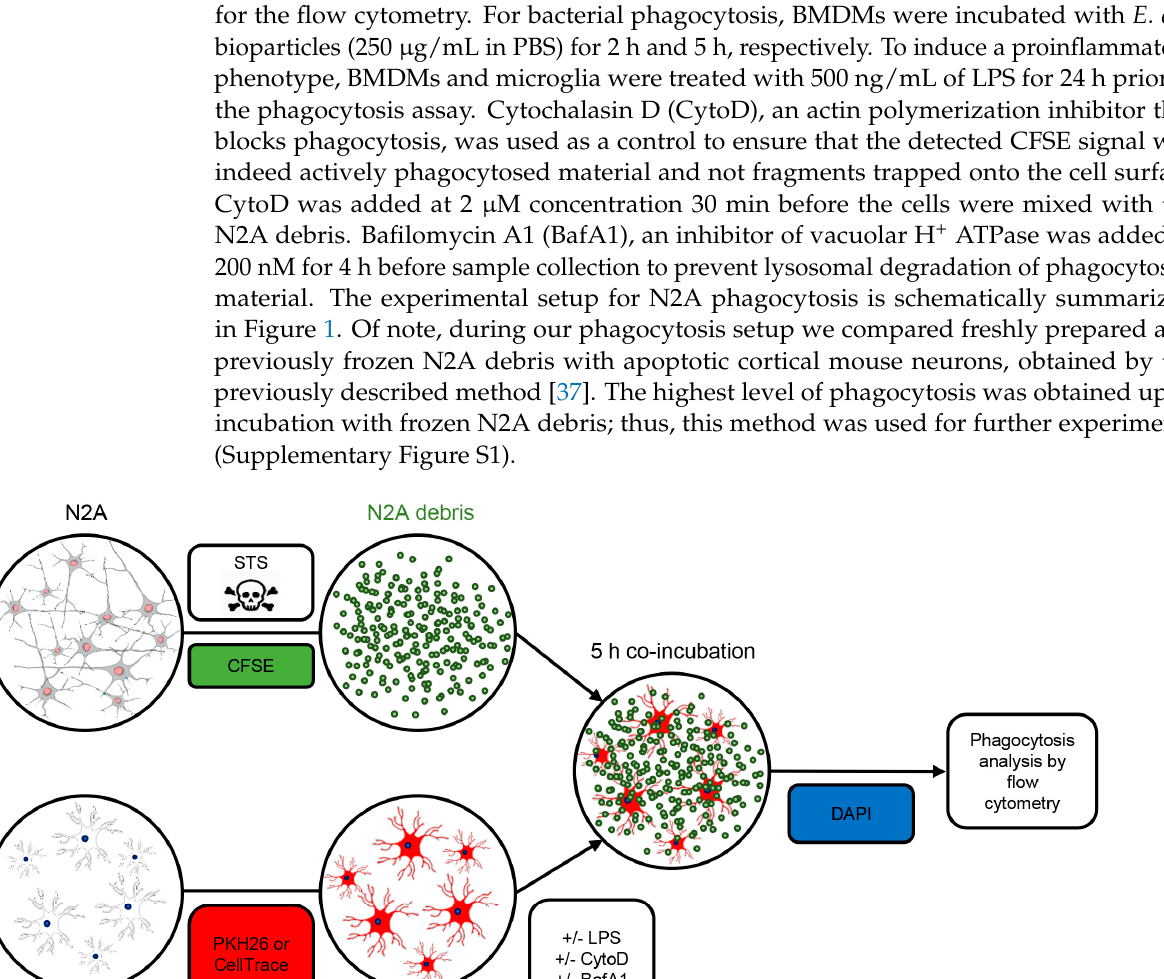
Figure 1. Setup for apoptotic cell phagocytosis assay. The Neuro2A (N2A) cells were treated with 2 μ M staurosporine (STS) for 24 h to cause apoptotic cell death. The N2A debris was frozen and